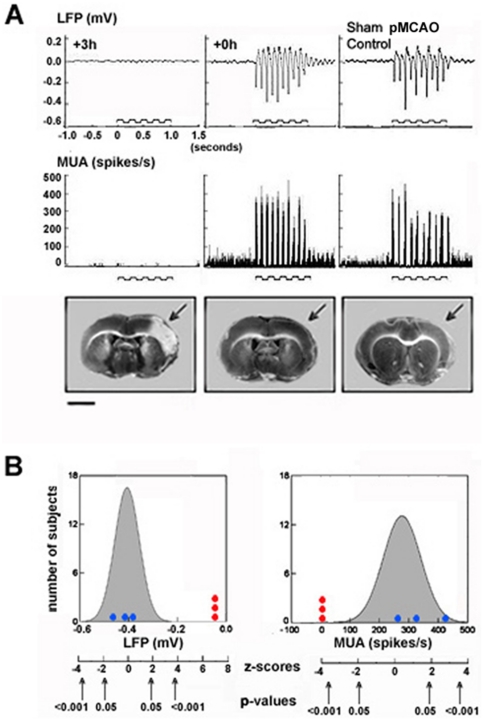
Normal evoked neuronal activity was maintained in all +0 h animals.(A) Representative +3 h, +0 h, and sham pMCAO control subjects' local field potential (LFP, first row) and multi-unit activity (MUA, second row) responses 24 hours following pMCAO. Stepping function indicates stimulus delivery. Representative coronal section taken from experimental and control animal's 2,3,5-Triphenyltetrazolium Chloride (TTC) assay for infarct. Area devoid of staining (arrows) within the +3 h subject's left cortex is indicative of ischemic infarct due to an occlusion of the left MCA. Scale bar indicates 5 mm. (B) LFP (left) and MUA (right) normal distributions based on sham pMCAO control data are plotted as shaded curves. Superimposed on these distributions are the individual values of +0 h subjects (blue circles) and +3 h subjects (red circles). Provided below each graph are the z-scores (as derived in relation to the normal distribution of sham pMCAO controls), and corresponding p-values.